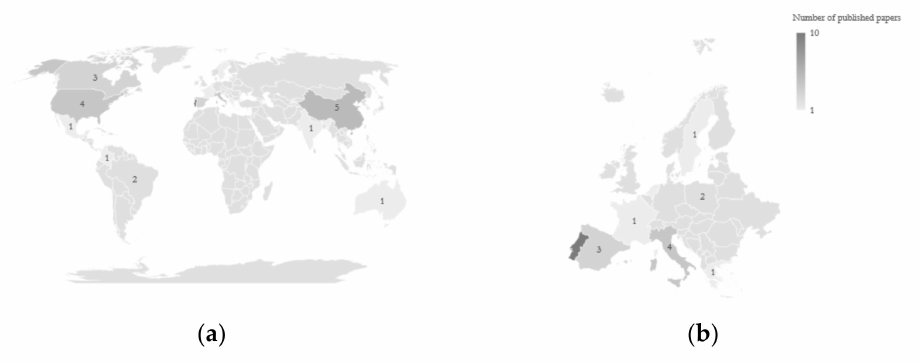
Figure 2. Number of studies performed by country at a global level ( a ) and in Europe ( b ).